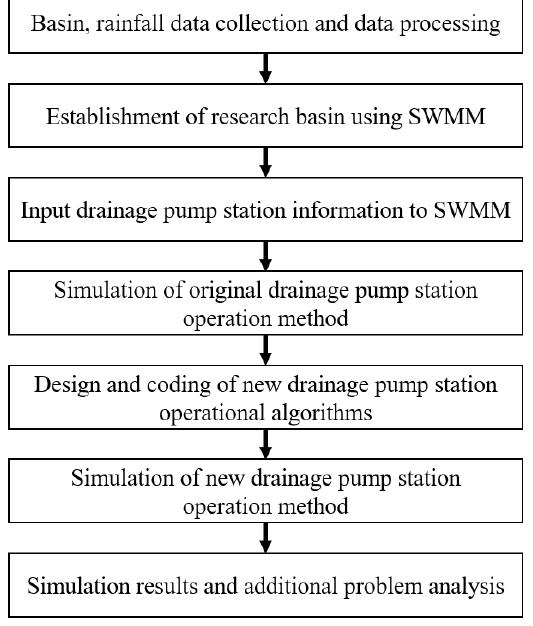
Figure 2. Research Flow.